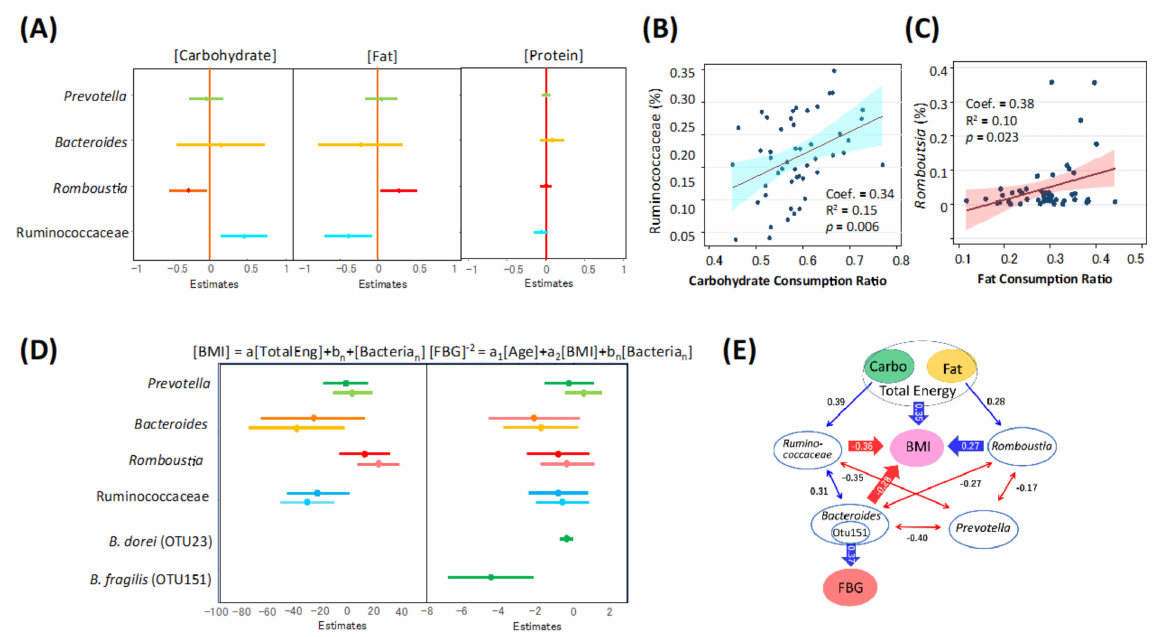
Figure 3. Association of intestinal bacteria with dietary macronutrients and host metabolic indices. ( A ) Single linear regression analysis was performed to estimate correlation of each bacteria group’s abundance to macronutrient consumption of the host using the dataset of non-T2D subjects. Estimates with CI95 were shown in the forest plot. ( B , C ) Scatter plot correlating with host carbohydrate consumption ratio and the abundance of Ruminococcaceae ( B ) and Romboutsia ( C ). CI95 range is colored. ( D ) Multiple linear regression analysis was performed to estimate the correlation of each bacterial abundance to BMI and FBG, respectively. Regression to BMI was estimated using the relative abundance of the four bacterial groups and host total energy consumption of non-T2D subjects. One subject (no. 303) was removed as an outlier to satisfy the assumption for linear regression. For regression to FBG, FBG values were converted to their inverse square values showing normal distribution and were then used as independent variables. The relative abundance of the four bacterial groups and host age and host BMI were used as dependent variables. The estimates with CI95 were shown (upper lines). Additionally, the relative abundance of the four bacteria and two Bacteroides species was solely used as the multiple regression analysis with host BMI and age and the estimates with CI95 were shown (lower lines for the upper four bacteria). ( E ) Path diagram showing correlations among the four driving bacterial groups, energies from diets, host BMI, and FBG. Red and blue arrows represent negative and positive correlations, respectively. The number besides the line shows the correlation coefficient between the connected two